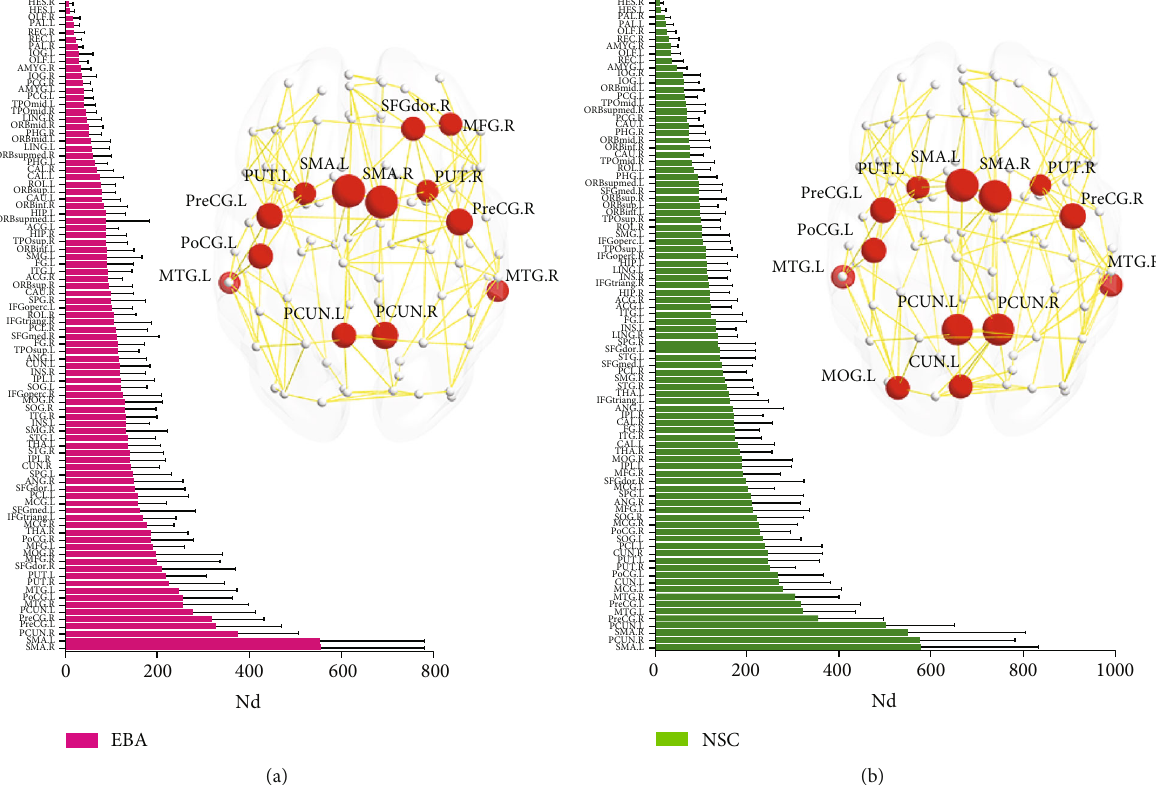
Figure 4: Hub region distributions (top 13) in the WM structural network in EBA (a) and NSC (b) cohorts. The left panels indicate the 90 brain regions of AAL atlas sorted by mean nodal degree (Nd) in ascending order for each cohort. The right panels show hub distributions of each cohort. The hub nodes are shown in red, and node sizes indicate the signi fi cance of intercohort di ff erence in Nd. The abbreviations of brain regions are presented in Table